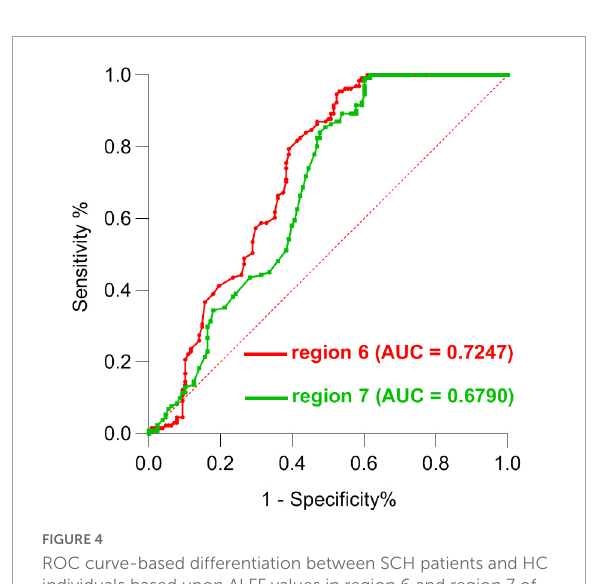
FIGURE4 ROC curve-based differentiation between SCH patients and HC individuals based upon ALFF values in region 6 and region 7 of the brain. ROC, Receiver operating characteristic; SCH, schizophrenia; HCs, healthy controls; ALFF, amplitude of low-frequency fluctuation; 6, bilateral precuneus; 7, left angular